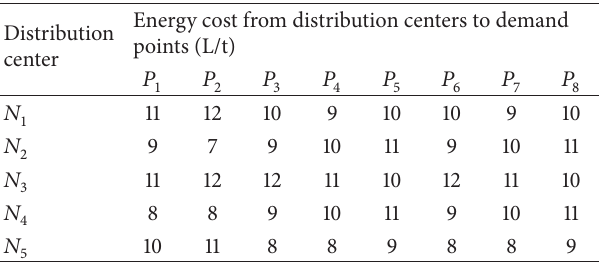
Table 4: Energy cost from distribution centers to demand points.